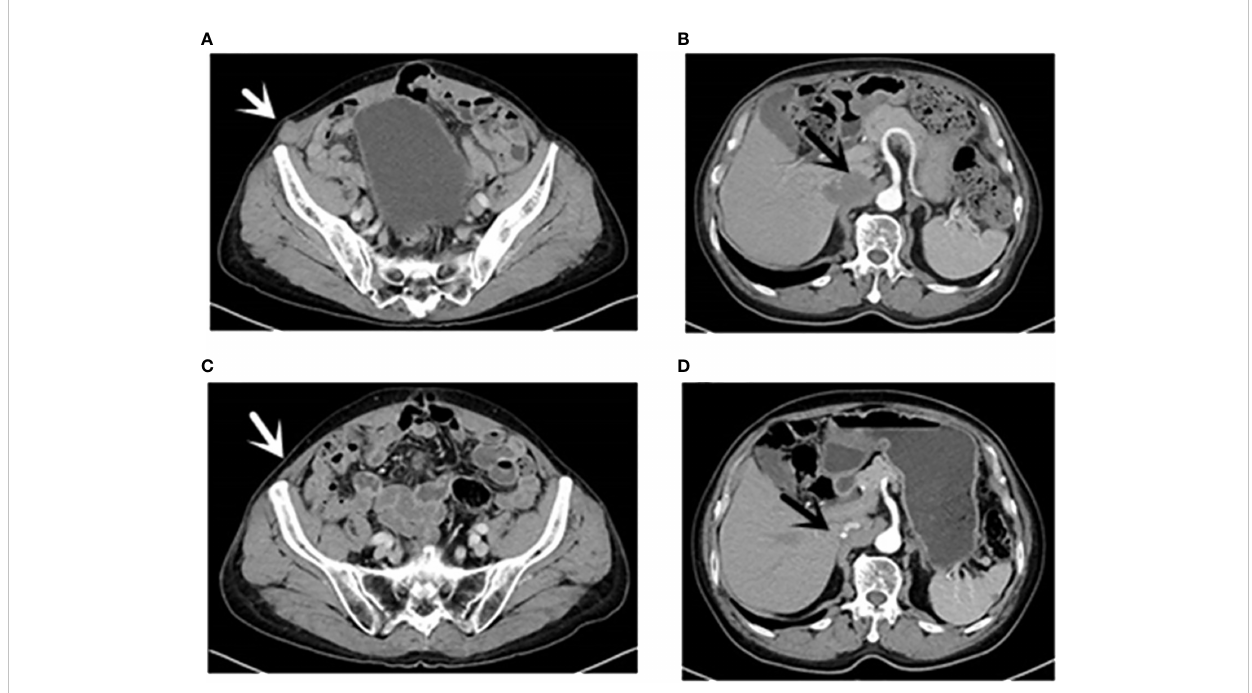
FIGURE 1 CT (16 August 2021): [ (A) , white arrow] Right inferior abdominal wall metastases; [ (B) , black arrow] hepatic caudate and inferior vena cava metastases and inferior vena cava invasion. CT (13 April 2022): [ (C) , white arrow] Right inferior abdominal wall; [ (D) , black arrow] the caudate lobe of liver and inferior vena cava. CT, computed